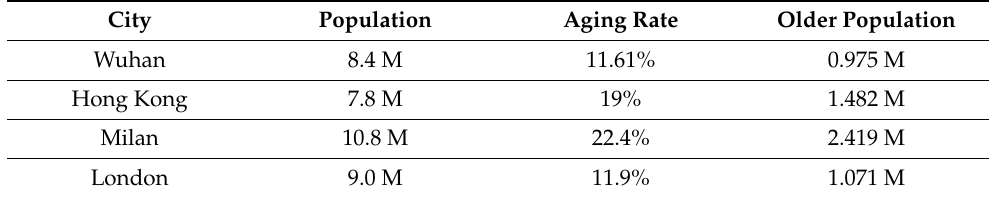
Table 2. Percentage of the population over 65 in 2021. City